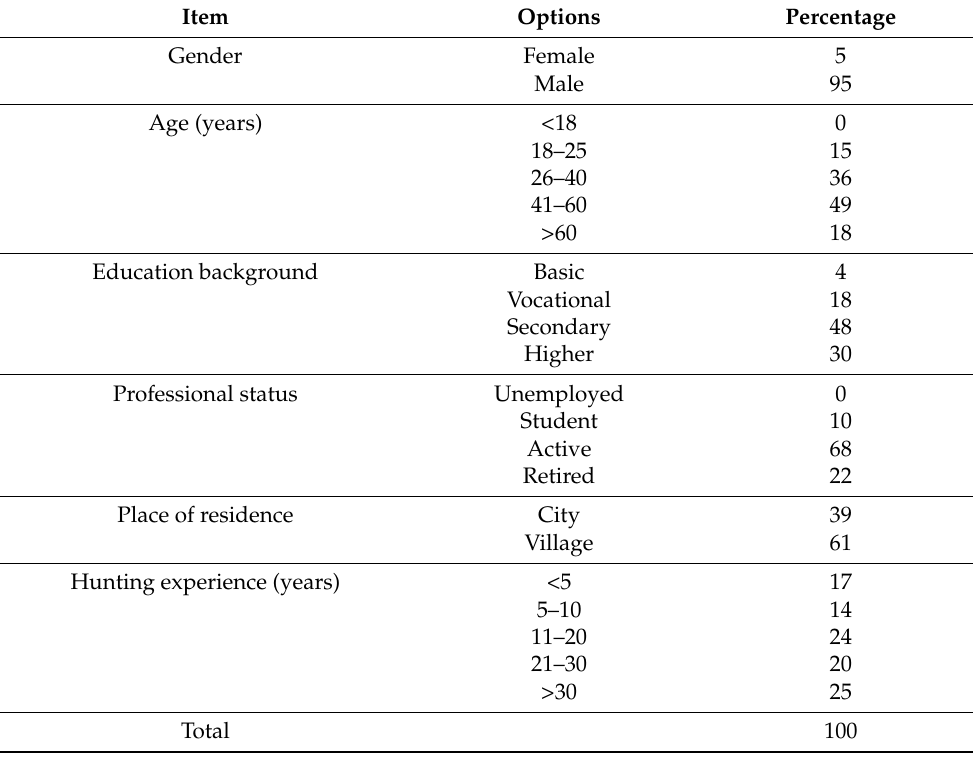
Table 1. Socio-demographic profile of hunters from the studied Region of Warmia and Mazury.